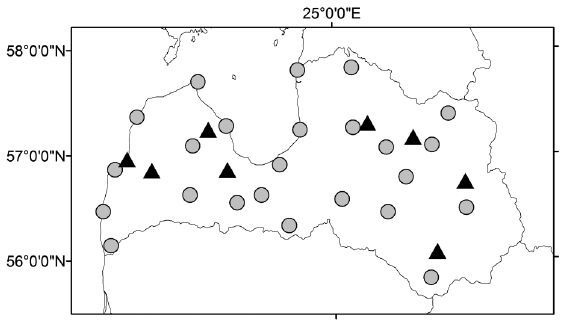
Fig. 1. Meteorological observation stations (circles) and strawberry phenological observation locations